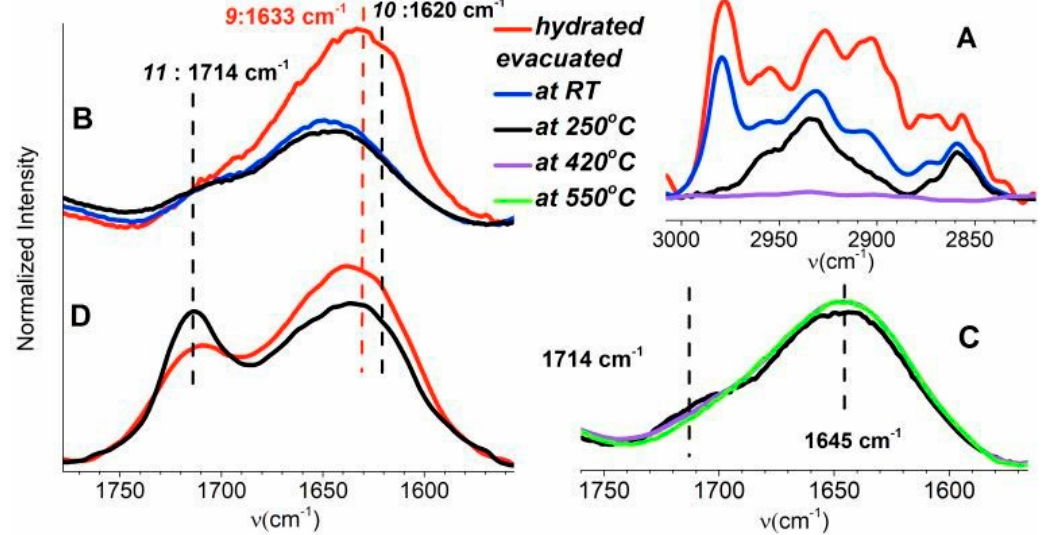
Figure 3. FTIR spectra of the samples with different treatments: C–H stretching vibrations of aliphatic hydrocarbons of SC-500 (panel A ); the skeletal overtone region of SC-500 (panel B ) and SF-500 (panel D ); and expansion of lines 9 and 11 of SC-500 (panel C